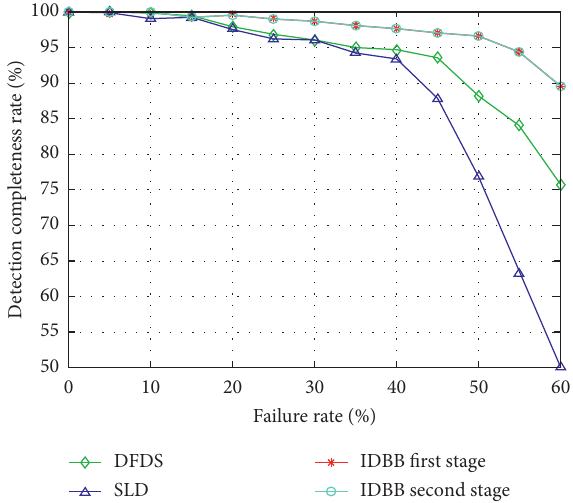
Figure 4: Relationship between detection completeness and failure